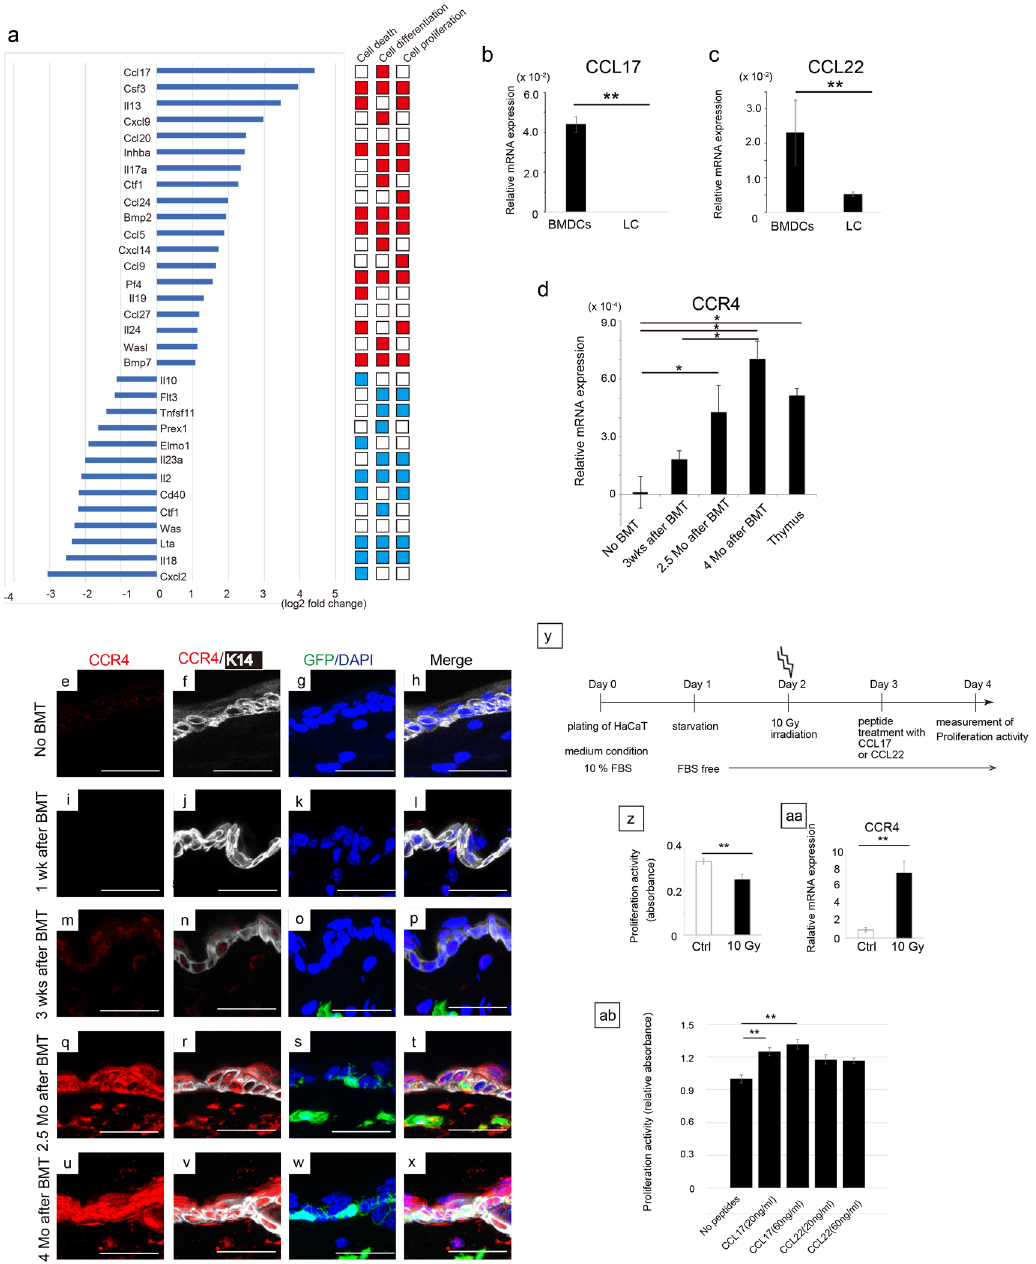
Figure 4. Crosstalk utilizing the CCL17-CCR4 axis between BMDCs and irradiated keratinocytes. ( a ) (Left panel) Partial results of microarray between BMDCs and LC are shown. (Right boxes) The function of each gene on cell death, differentiation, and proliferation reported on mouse genome informatics (http://www.infor matic s.jax.org/) is visualized in colors; red color indicates positive effects, while blue color indicates negative effects on each function. mRNA samples were collected from mice 2.5 months after BMT (n = 3, respectively). ( b , c ) CCL17 and CCL22 were significantly expressed in BMDCs, compared with LC. ( d ) CCR4 was induced in basal cells time-dependently after BMT. CCR4 expression in the thymus was compared as a positive control. wks; weeks, Mo; months. ** P < 0.01, * P < 0.05. ( e – x ) Immunostaining with anti-CCR4 (red), anti-K14 (white; pseudo- color), GFP (green), and DAPI (blue) was performed using the skin of BMT mice at various time points. CCR4 was strongly expressed in the entire epidermal cells as well as in dermal cells 2.5 months and 4 months after BMT. Scale bars, 50 µm. ( y ) In vitro experimental protocol using the HaCaT cell line. ( z ) 10 Gy of IR suppressed proliferation activity of HaCaT. ( aa ) CCR4 was induced upon 10 Gy IR exposure in HaCaT on day 3. ** P < 0.01. ( ab ) CCL17, but not CCL22, significantly recovered cell proliferation compared with no treated irradiated HaCaT. Experiments repeated twice. ** P < 0.01. BMT, bone marrow transplantation; BMDCs, bone marrow- derived cells; LC; Langerhans